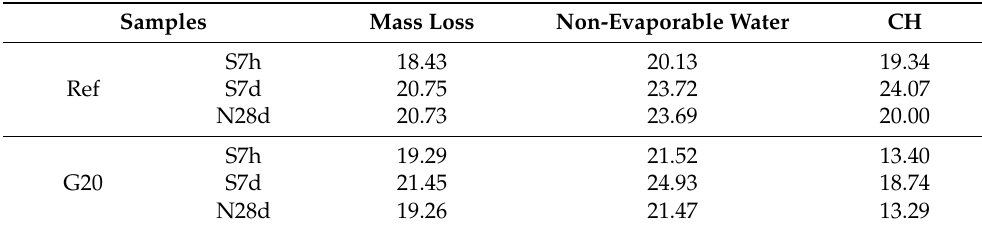
Table 3. Total mass loss, non-evaporable water, and CH content of cement pastes, wt.%.